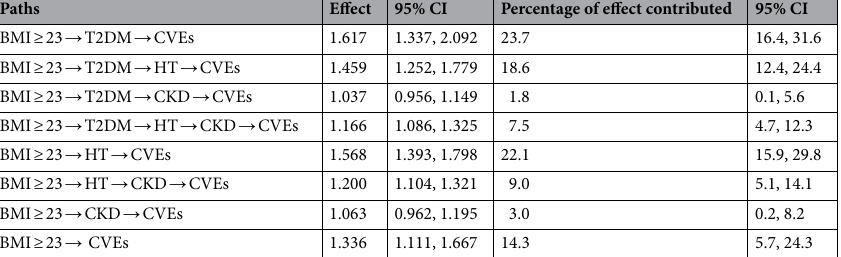
Table 5. Estimation of mediation effects and contribution of each pathway relative to total effects of excess body weight on cardiovascular events. BMI body mass index, CKD chronic kidney disease, CVEs cardiovascular events, T2DM diabetes mellitus, HT